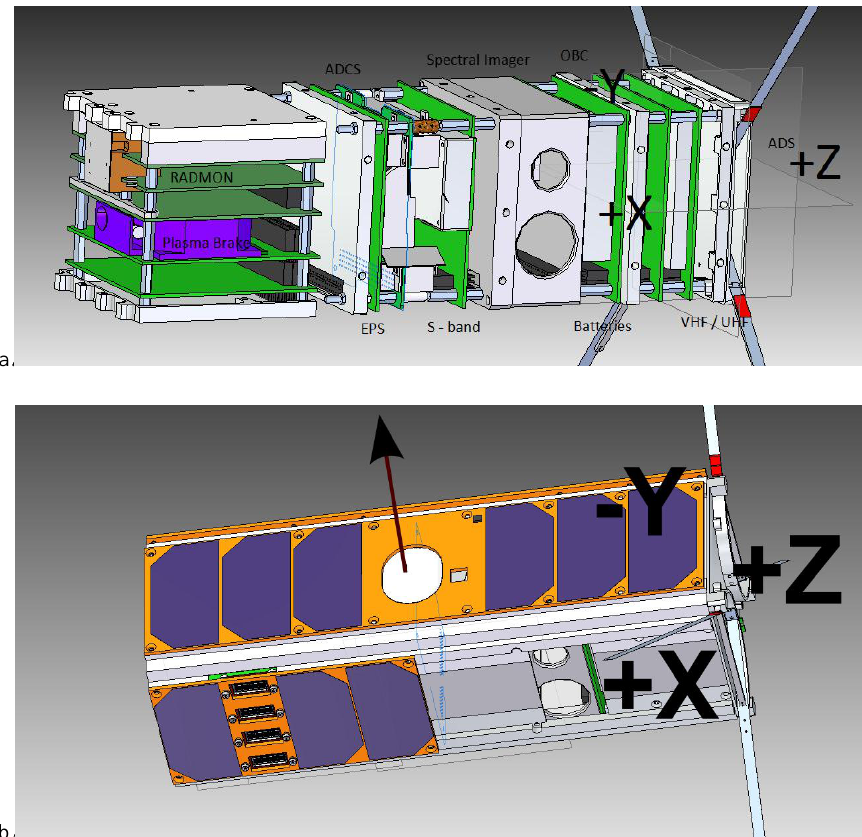
Fig. 1. (a) A exposure of the Aalto-1 subsystems, in which EPS is the electrical power system, OBC the onboard computer and ADS the antenna deployment system (GPS receiver will be integrated with the S-band board). (b) The satellite’s external dimensions are 10 × 10 × 34cm. (The position of ADCS star tracker is at the centre of the − Y-side alongside the smaller GPS antenna, represented here by the bigger and smaller holes, while the electron guns are at the left side of the +X-side.) The satellite’s velocity vector will be parallel to its − Y